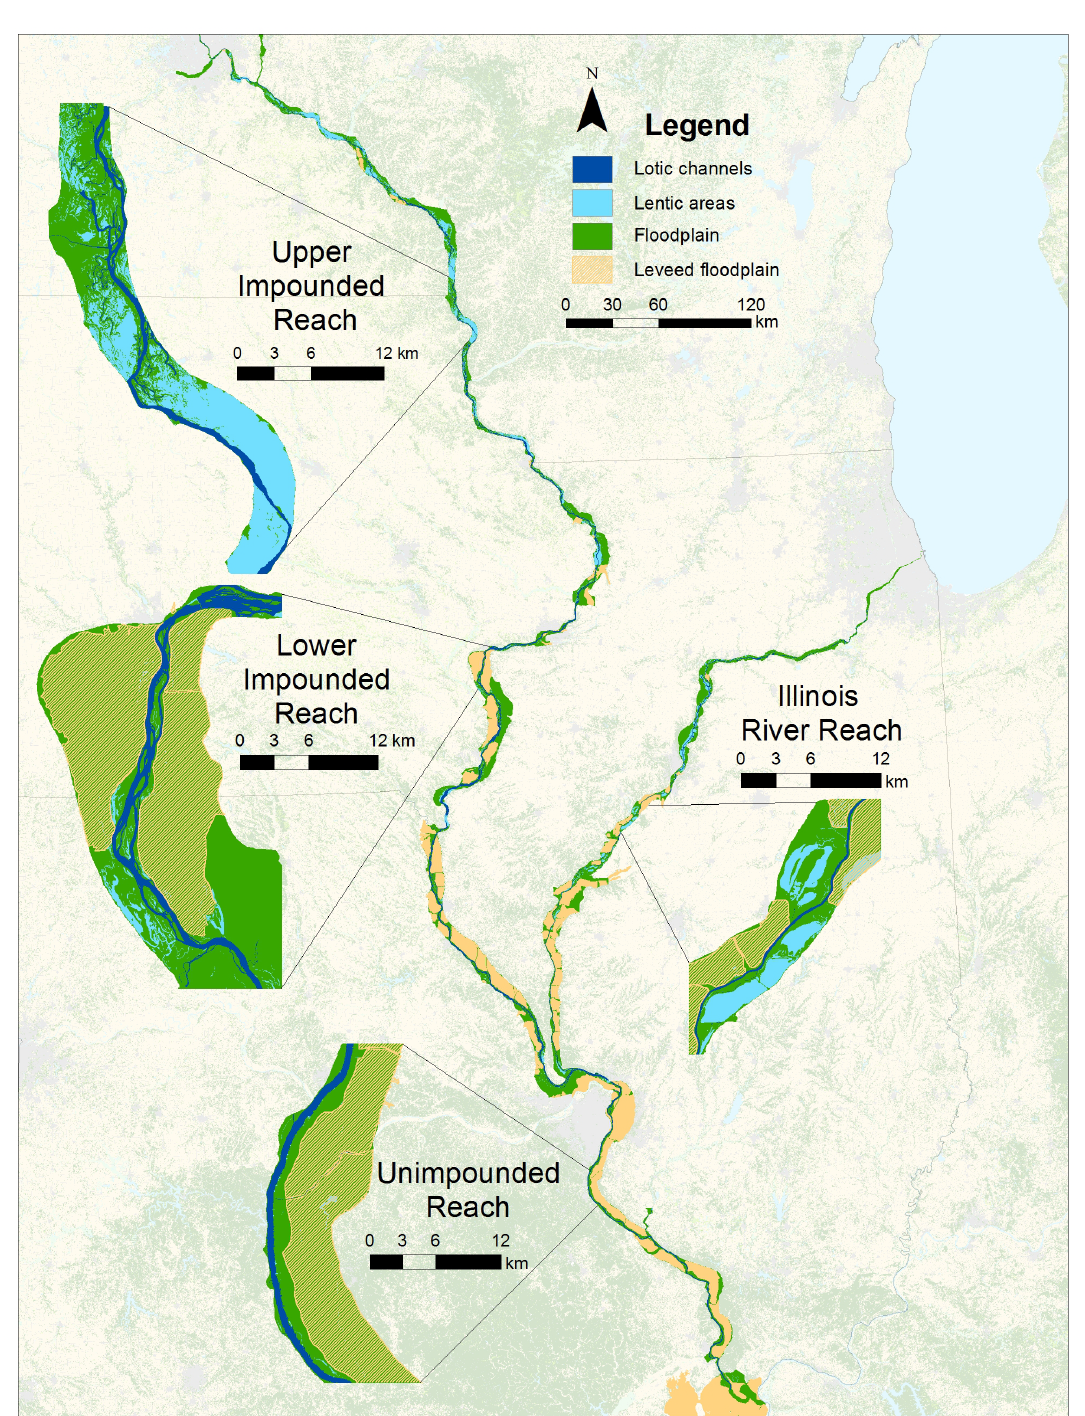
Fig. 8 . An example of the mosaic lotic channels, lentic areas, and floodplains for segments of the river that represent the four floodplain reaches. The orange hashed areas represent floodplains disconnected from the main channel by